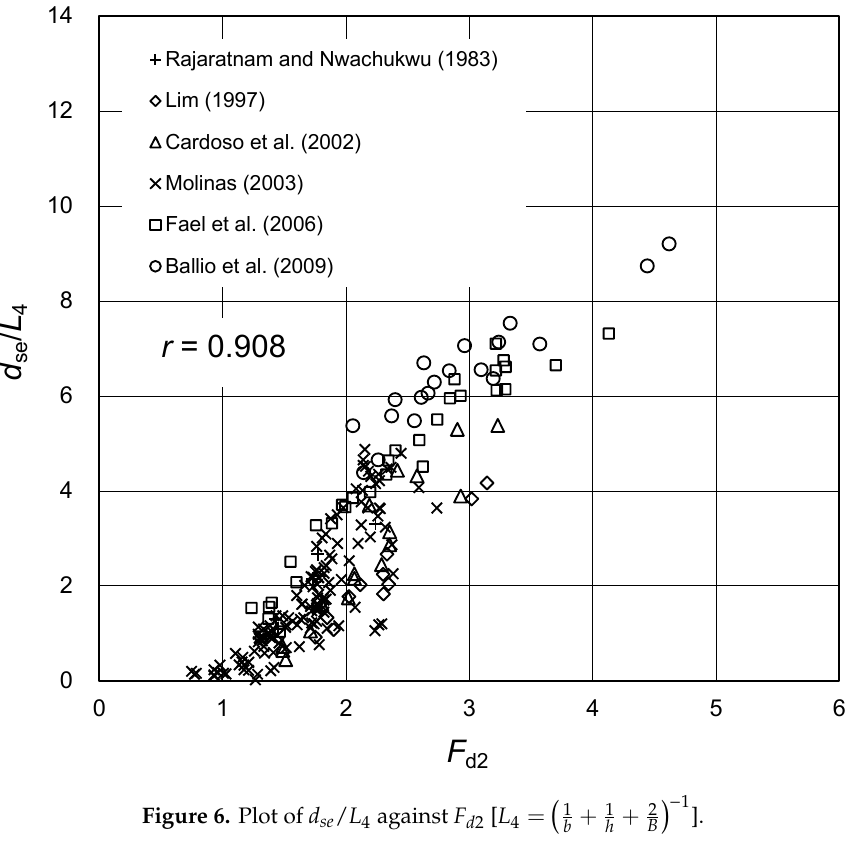
Figure 6. Plot of (cid:1856)